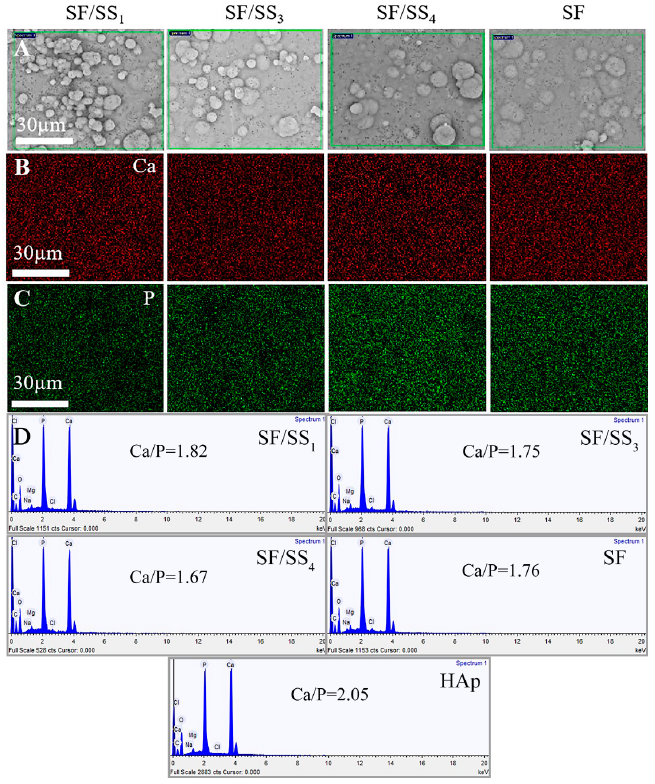
Figure 8. The distribution of growing crystals and elements after mineralization for 7 d. ( A ) SEM images of growing crystals, ( B ) Distribution of Calcium, ( C ) Distribution of Phosphorus, ( D ) Ca/P